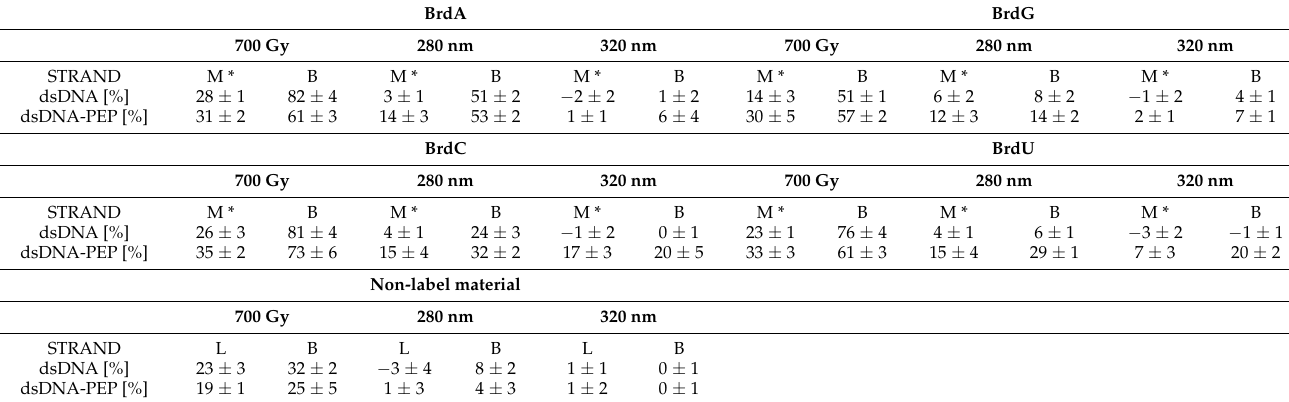
Table 1. Degradation rate [%] of all analyzed systems by means of HPLC—X-ray, UV (280 and 320 nm). Strand labeled “B” corresponds to the ssDNA B (see Materials and Methods) and is the same for all of the double stranded DNA molecules. Strand “L” corresponds to the ssDNA A or ssDNA A* for dsDNA- and dsDNA-PEP, repectively (see Materials and Methods). Strand “M *” corresponds to ssDNA-BrdA, ssDNA-BrdC, ssDNA-BrdG, ssDNA-BrdU respectively, with or without conjugation (dsDNA vs dsDNA-PEP). The degradation rate is the % of peak area of material which was exposed to radiation to material which was not exposed to